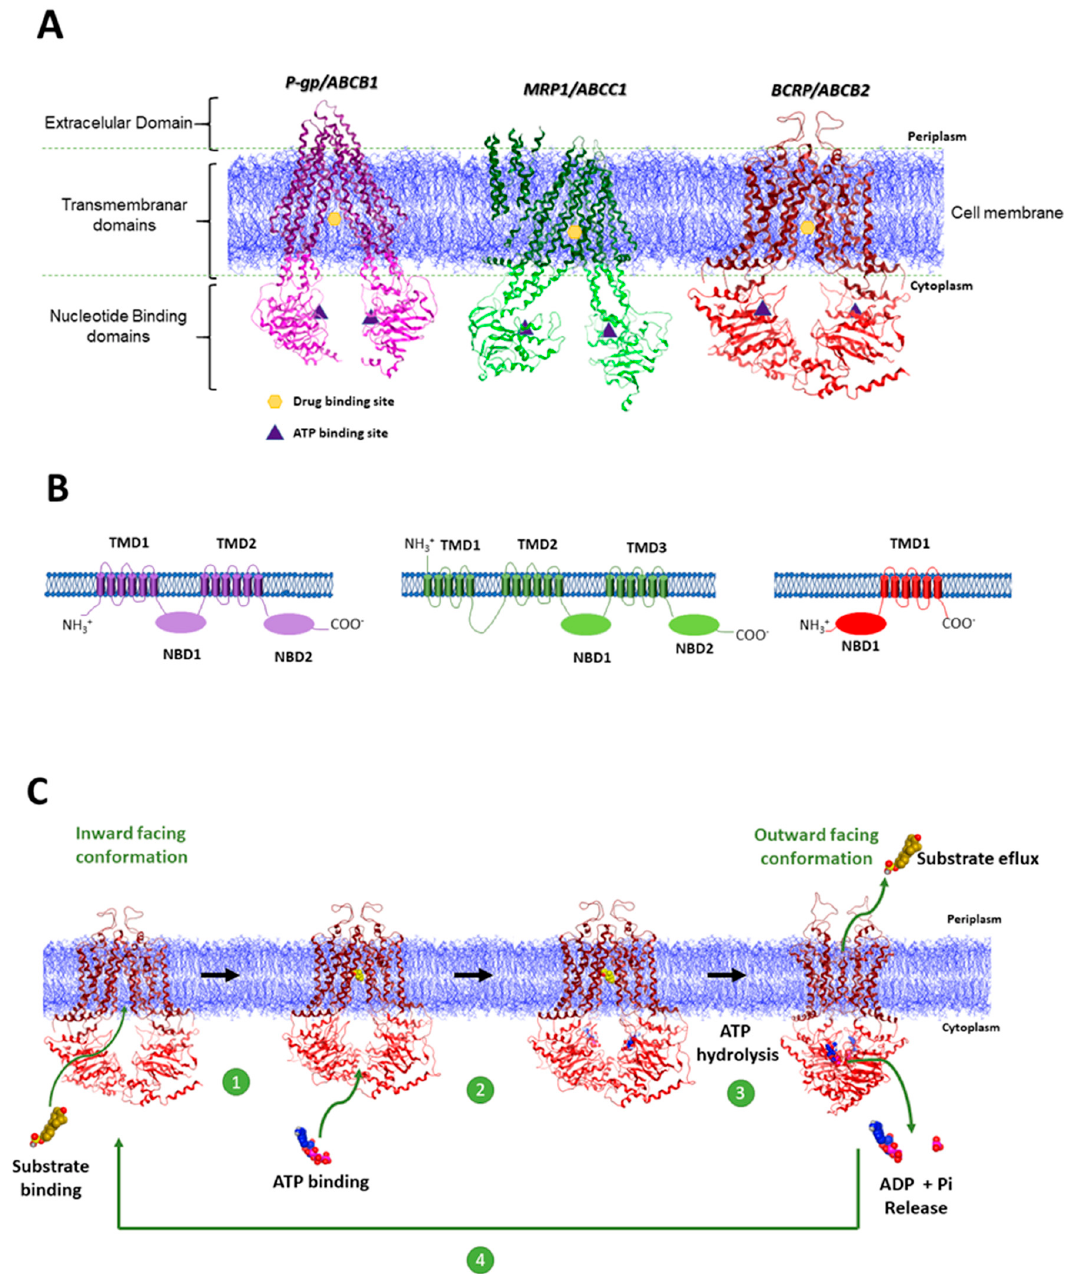
Figure 1. ( A ) High resolution 3D structures of the mouse P-gp (PDB-ID:5KPI) [20], which has 87% sequence identity to human P-gp; bovine MRP1(PDB-ID:5UJ9) [21], which has 91% protein identity with the human protein; and human BCRP (PDB-ID:5NJ3) [22]. The NBD domains for each protein are depicted in light purple (P-gp), light green (MRP1) and light red (BCRP), whereas the TMD domains are depicted in the dark variations of the same colors. Cell membrane is depicted in blue. Adapted from: Nat Rev Cancer 18, 452–464 (2018) [9]; ( B ) Membrane topology models of P-gp, MRP1, and BCRP proteins. P-gp possesses two homologous halves, each containing a TMD consisting of six putative membrane-spanning α -helices at the N -terminus and a cytosolic hydrophilic NBD at the c-terminus that are involved in binding and hydrolyzing ATP. MRP1, in addition to the two NBD and two TMD containing six α -helices, is composed by and extra TMD consisting of five α -helices. The half transporter BCRP contains one TMD of six α -helices and one NBD. The ATP-binding site of this transporter is found on the amino-terminal side (N) in contrast to P-gp and MRP1. Was adopted the same color scheme used in A. ( C ) Simplified representation of the ABC drug efflux mechanism using